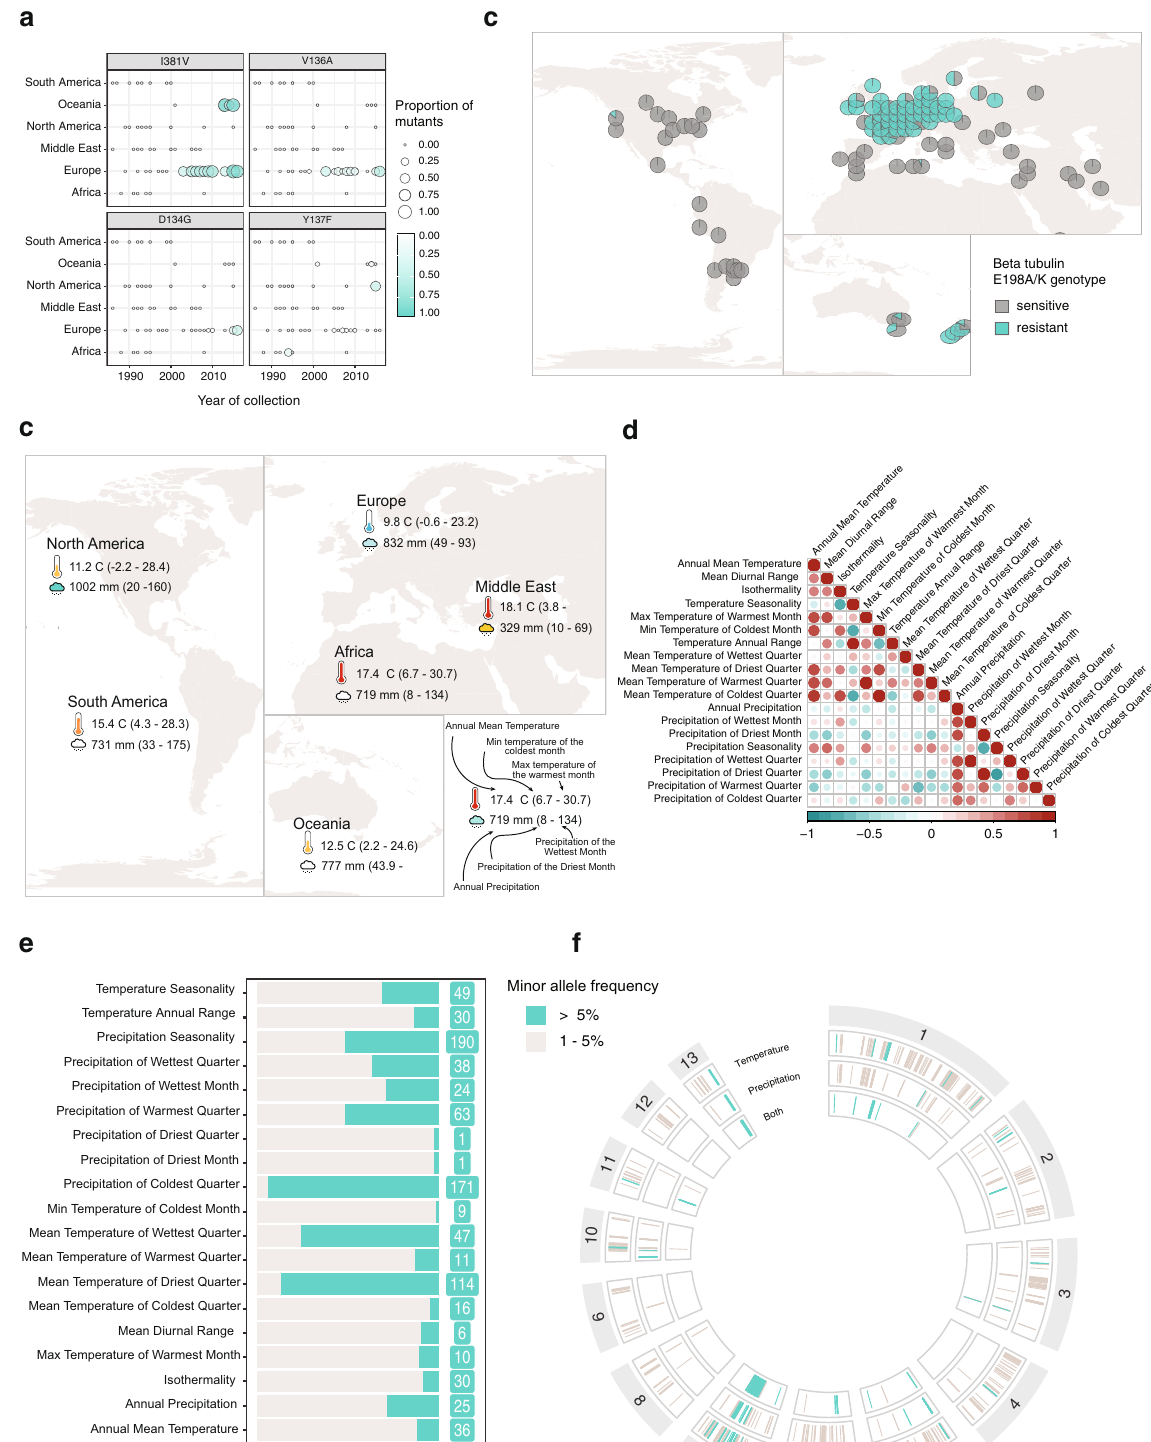
Fig. 5 | Adaptation to fungicides and climatic gradients. a Frequency of muta- tions underlying azole fungicide resistance across time and regions. b Map representing the allele frequency of known beta-tubulin resistance mutations (E198A/K) against benzimidazole fungicides. c Examples of bioclimatic variables used for the genotype-environment association analyses among regions. The valuesrepresenttheaverageforeachcontinent. d Correlationplotbetweenthe19